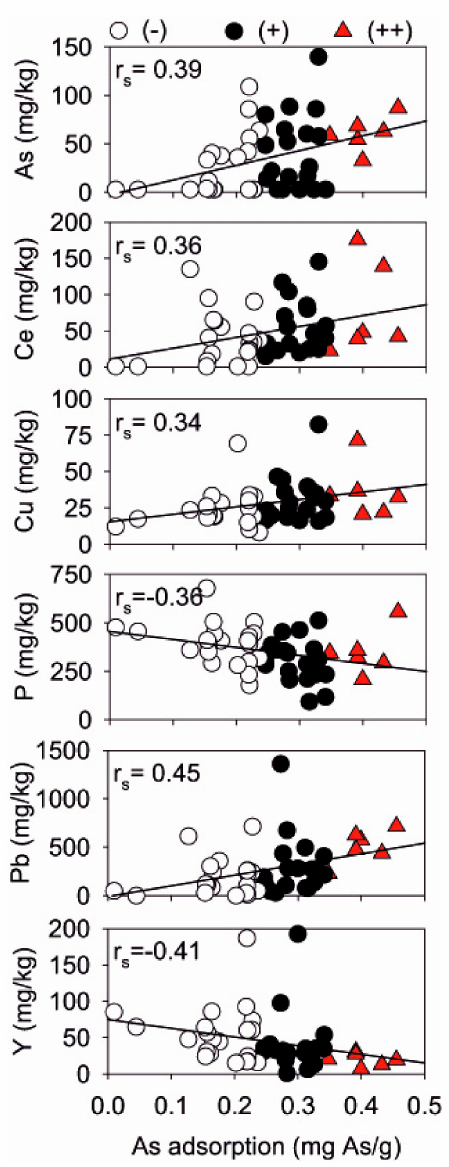
Figure 4. Bivariate plots and significant Spearman correlations (r s ) between the As adsorption potential and the content of selected trace elements ( p < 0.02, always). Symbols indicate samples not suitable (-), suitable ( + ), and promising ( ++ ) for As